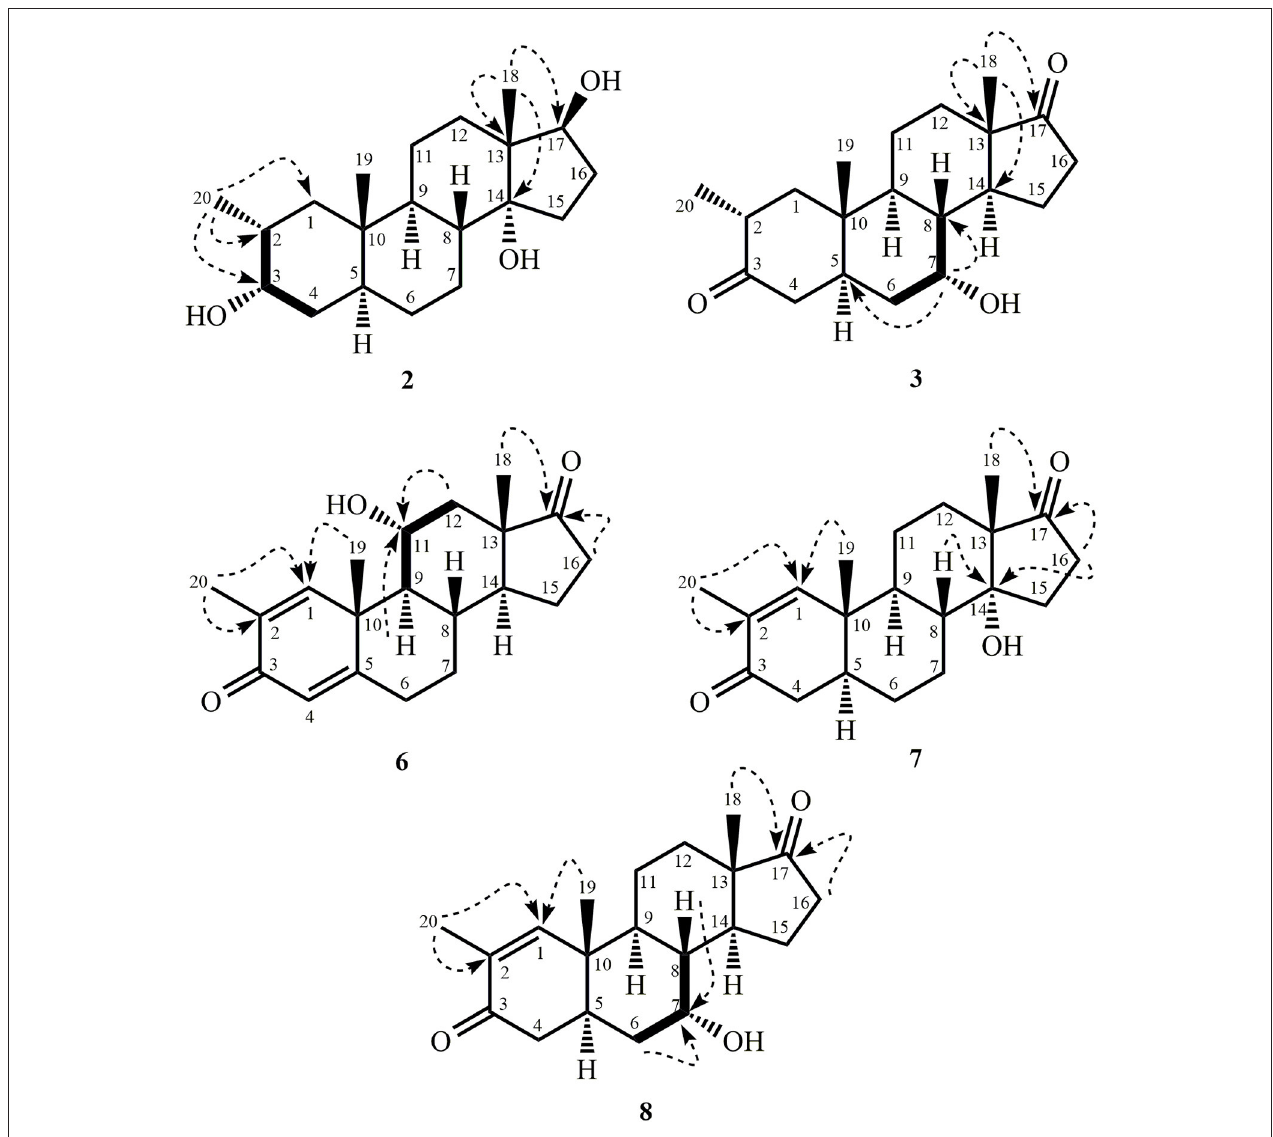
FIGURE 3 | Key HMBC ( ), and COSY ( ) correlations in new